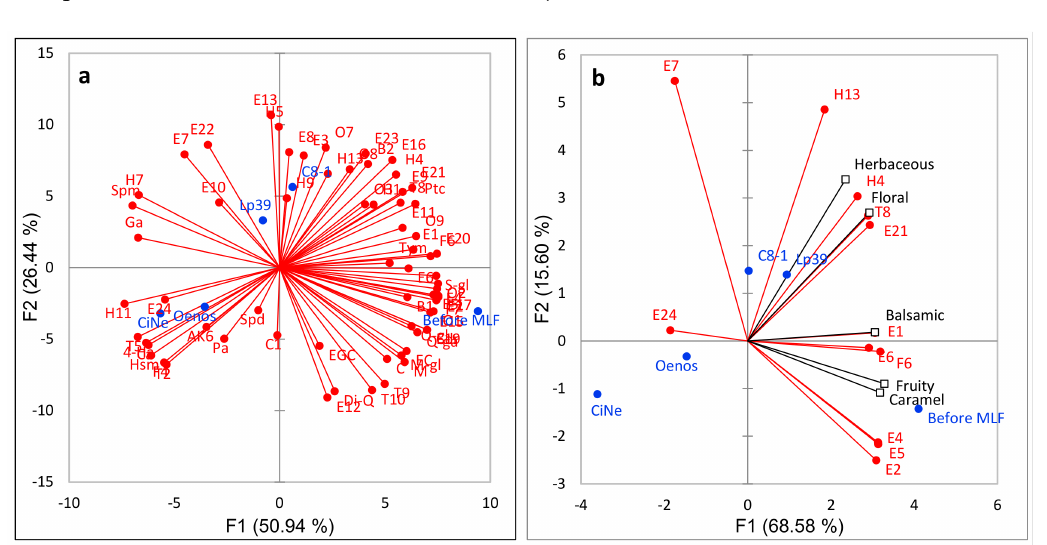
Figure 2. Principal component analysis of phenolic compounds, biogenic amines, and volatile compounds in Cabernet Gernischt wine before and after malolactic fermentation using L. plantarum (C8-1 and Lp39) and O. oeni (Oenos and CiNe) ( a ). Volatile compounds with significant odor activity value (OAV) contributions are plotted in ( b ) using aroma series (black vectors) as supplementary variables. Only the variables (red vectors) with significant di ff erence among samples (blue spots) are included in both biplots. Abbreviations: Before MLF, before malolactic fermentation; B1, Procyanin B1; B2, Procyanin B2; C1, Procyanin C1; C, Catechin; EC, Epicatechin; EGC, Epigallocatechin; M, Myricetin, M-gl, Myricetin-glucoside, Q-ga, Quercetin-galactoside; Q-gl, Quercetin-glucuronide; Di-Q, Dihydroquercetin, S-gl, Syringetin-glucoside; Ga, Gallic acid; Pa, Protocatechuic acid; Ca, Ca ff eic acid; 4-Ha, 4-Hydroxycinnamic acid; Hsm, Histamine; Spm, Spermine; Spd, Spermidine; Tym, Tyramine; Ptc, Putrescine; Cdr, Cadaverine. Codes of volatile compounds refer to Table